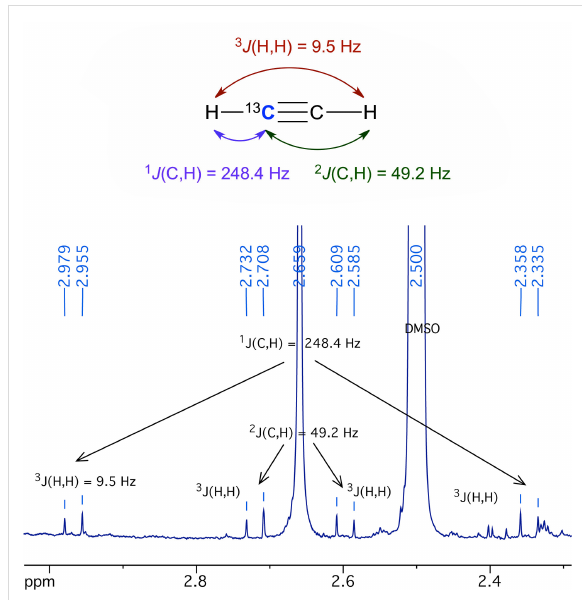
Figure 3: Identification of ethyne ( 2 ) in the reaction solution by cou- pling pattern analysis of 13 C-satellite signals.